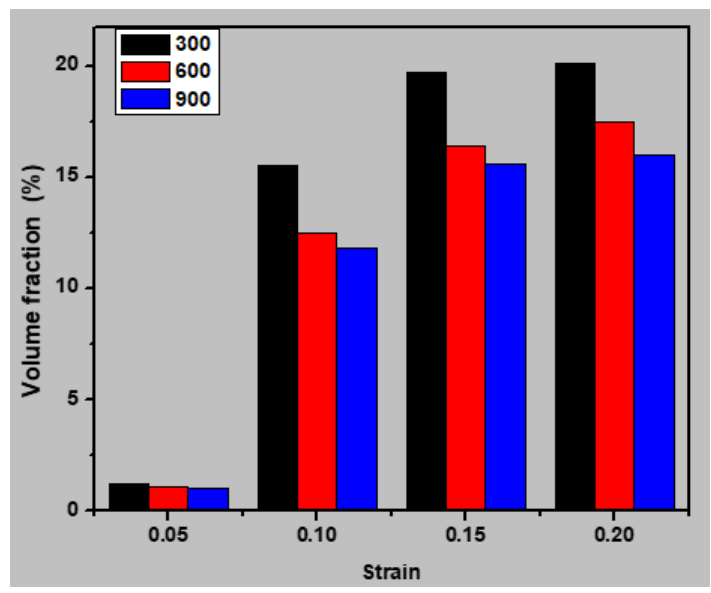
Figure 16. Volume fraction of twins and stacking faults (hcp) in the sample with an average grain size of 7.7 nm for various strains and temperatures (300, 600, and 900 K).